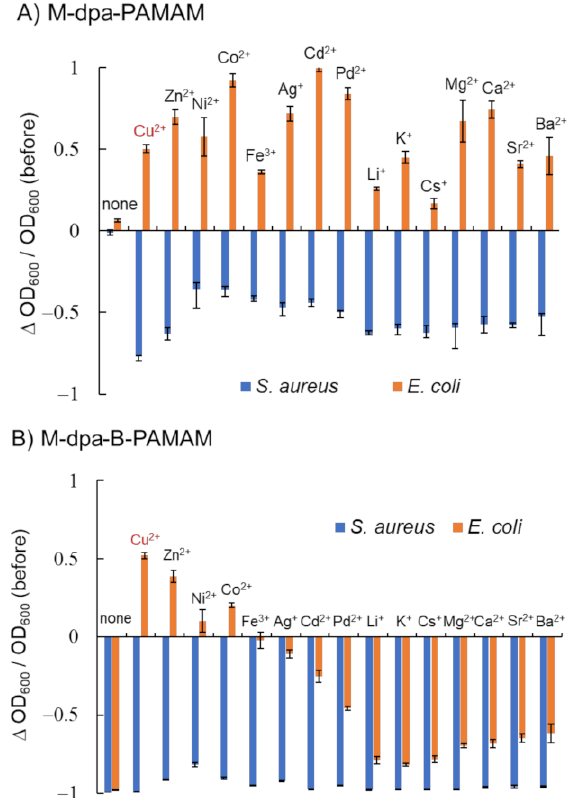
Figure 4. Turbidity changes in bacterial suspensions containing dpa-modified probes at pH 7.4 adjusted with HEPES buffer ( n = 3). [probe] = 3.3 µ M; [bacteria] = 2.3 × 10 8 CFU · mL − 1 ; [(M)(NO 3 ) n ] = none or 13.2 µ M; [HEPES] = 5.0 mM. Bars are expressed as SD for three